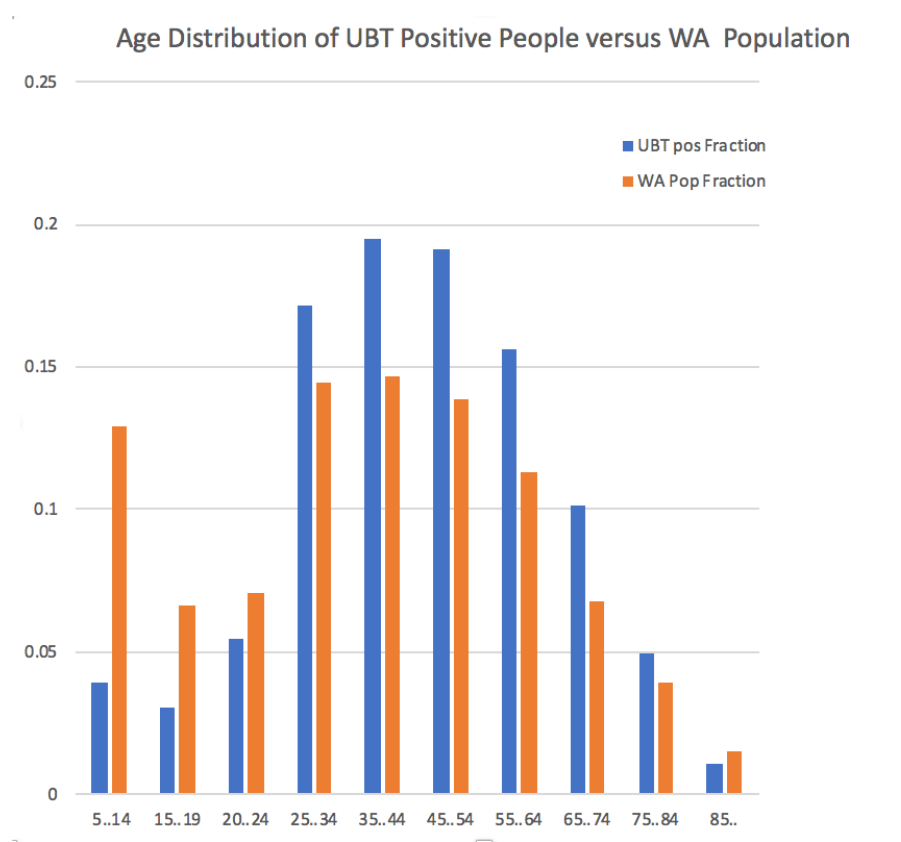
Figure 1. H. pylori positive results by age group. Percentage of UBT positive individuals across age ranges spanning 5 years to 85 years and older, compared with the percentage of individuals for the respective age ranges based on the 2011 Australian Census data for Western Australia. The age ranges are those used by the Australian Bureau of Statistics in reporting results from the